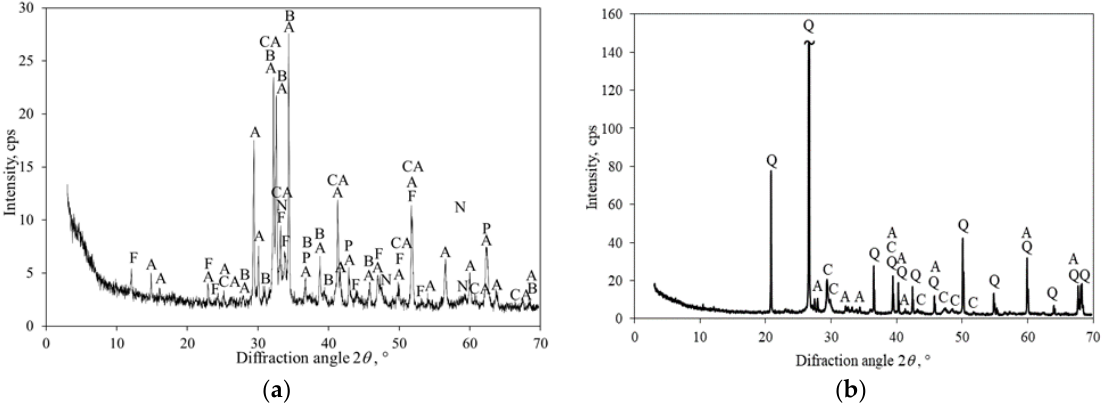
Figure 12. XRD patterns of JSC Akmenes cementas OPC clinker ( a ) and after 24 h of carbonization of samples at 45 °C ( b ). Indexes: A—alite, B—belite, CA—tricalcium alumina, F—calcium aluminum iron oxide, P—periclase, N—sodium calcium aluminum oxide, C—calcite, Q—quartz.